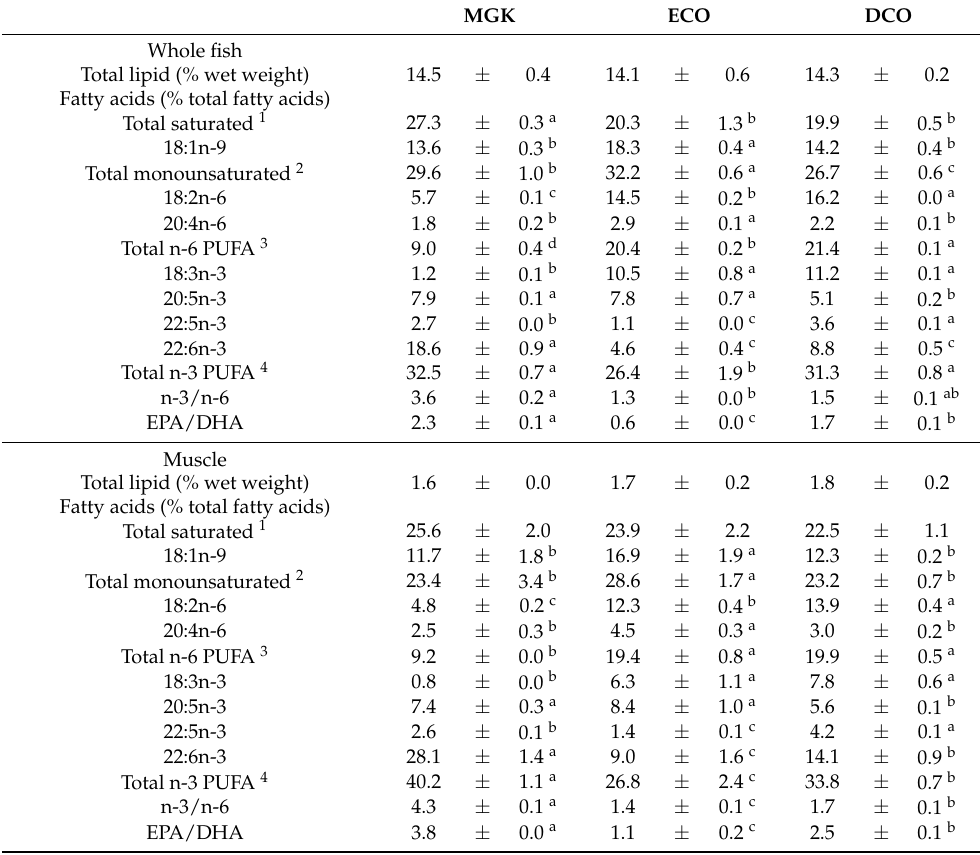
Table 4. Total lipid contents (% wet weight) and fatty acid compositions (% of total fatty acids) of Atlantic bluefin tuna ( Thunnus thynnus L.) juveniles and muscle after 18 days of feeding the reference (MGK) and experimental feeds containing GM Camelina sativa oils containing high EPA (ECO) or EPA + DHA